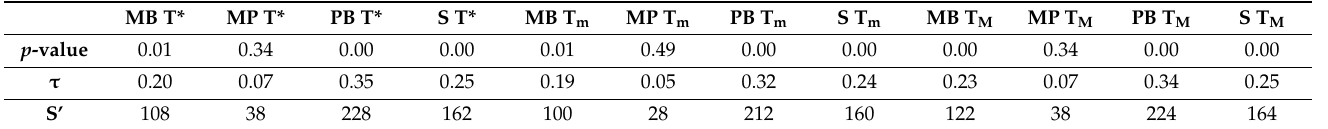
Table 5. Mann–Kendall seasonal test results: the alpha value has been set to 0.05; in bold the significant p -values; average daily temperature ( T* ), average daily minimum temperatures ( T m ) average daily maximum temperatures ( T M ) at the weather stations ( MB , MP , PB , S ).